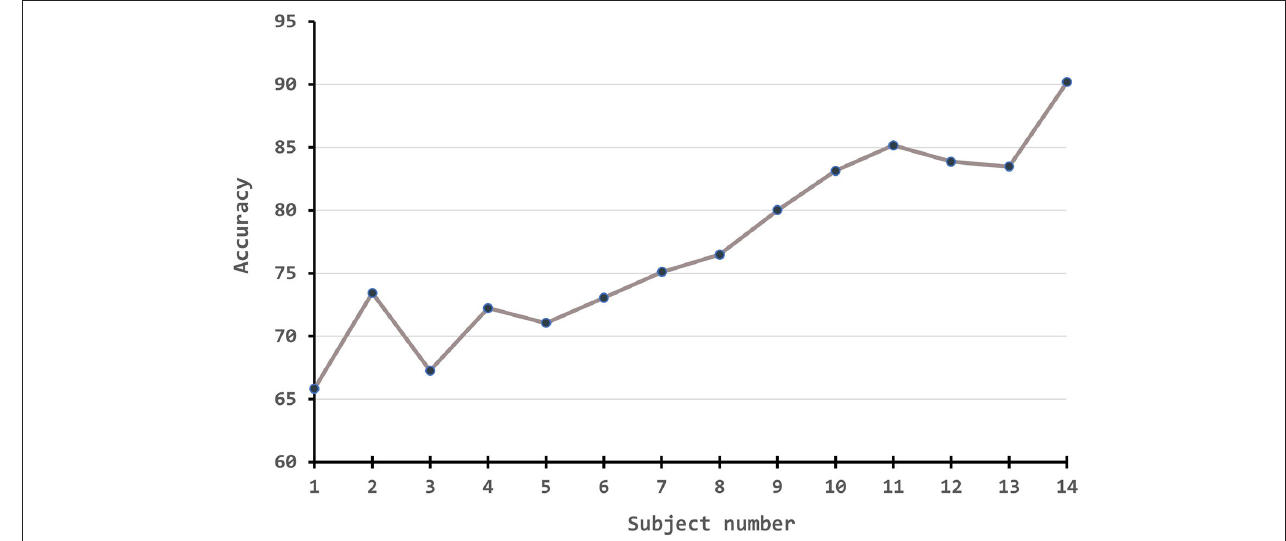
FIGURE 4 | The performance measures change along with the number of source